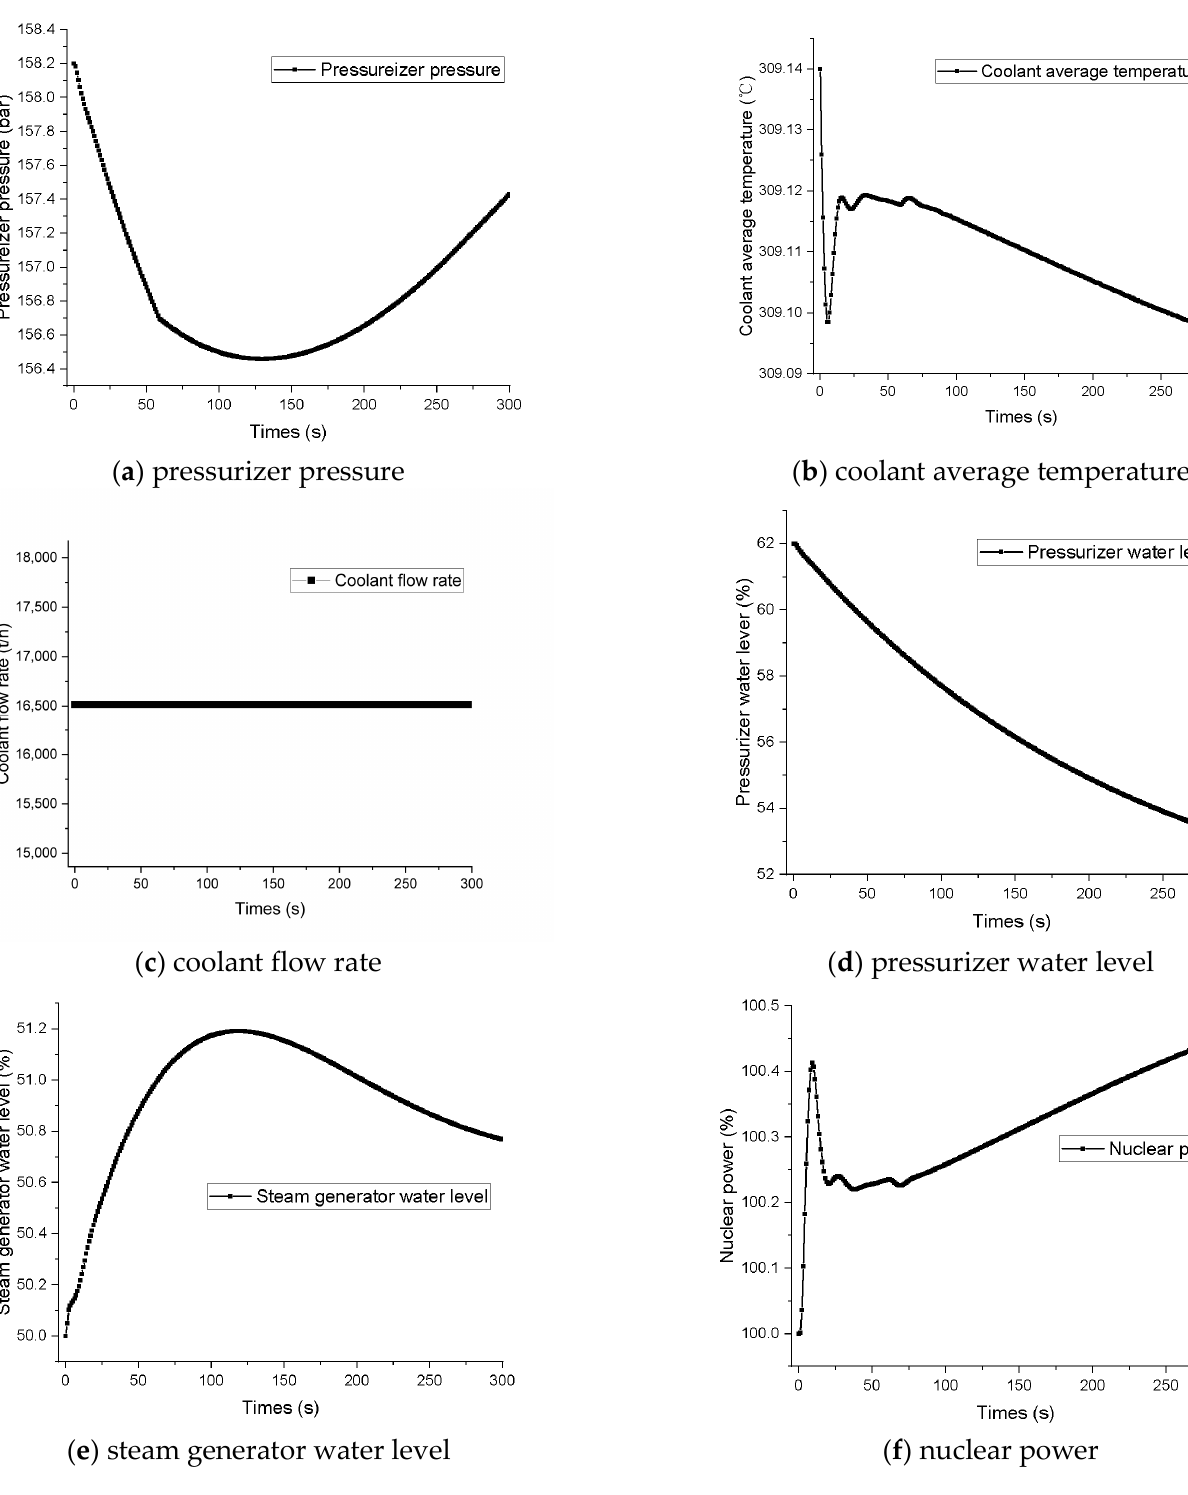
Figure 8. Operating trend of steam generator tube rupture.